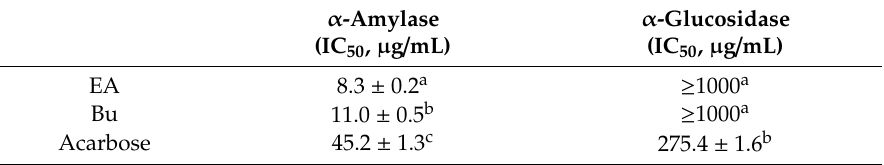
Table 4. Inhibitory activities of S. tenuipes fractions towards α -amylase and α